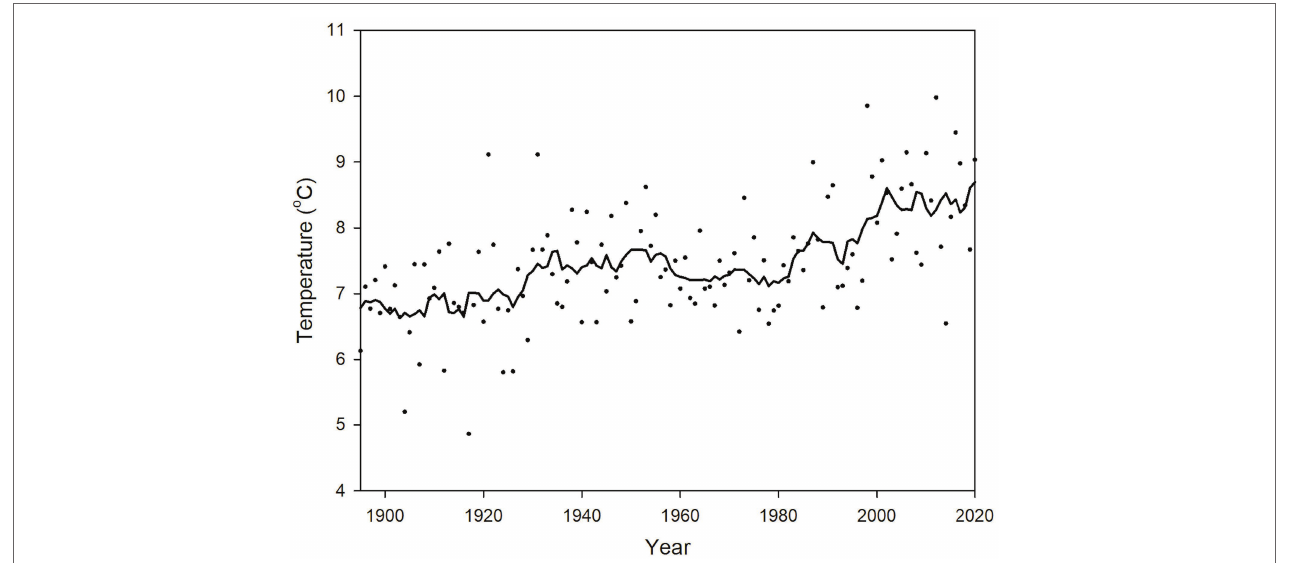
FIGURE 2 | Annual mean temperatures ( ° C, depicted by dots) spatially averaged across the Lower Peninsula of Michigan, 1895–2020. A 9-year, uniformly weighted moving average is given by the solid black line. Data are based on NOAA NCEI Climatological Division data series (NOAA NCEI,